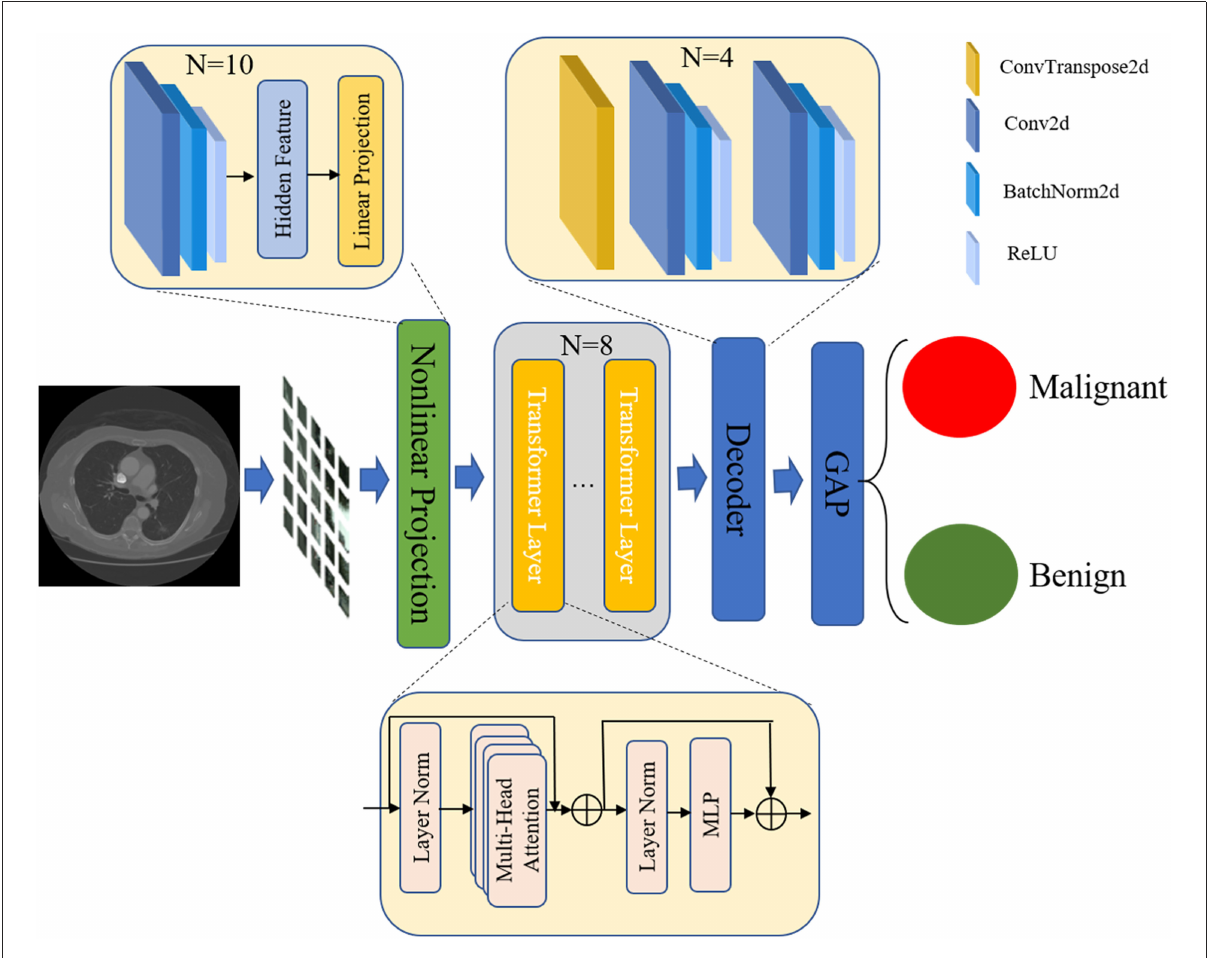
FIGURE2 The architecture of TransUnet.